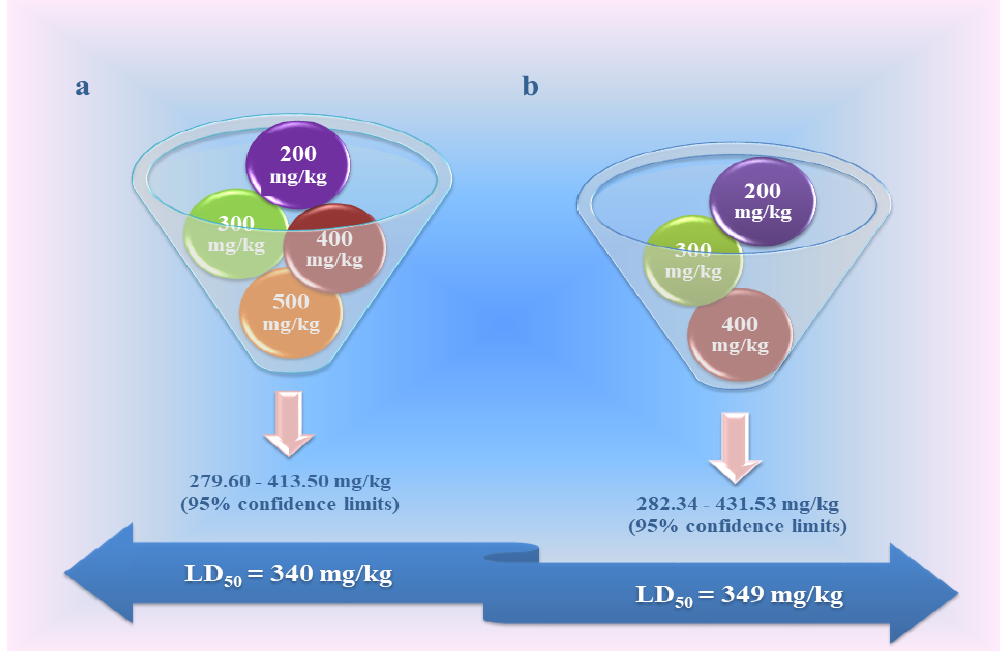
Figure 6. Twenty-four-hour median lethal dose (LD 50 ) of fullerenol nanoparticles (FNPs) for an intraperitoneal (i.p.) route of administration; ( a ) calculated LD 50 value after the application of four increasing doses of FNPs [178]; ( b ) calculated LD 50 value after the application of three increasing doses of FNPs [179], original figure.